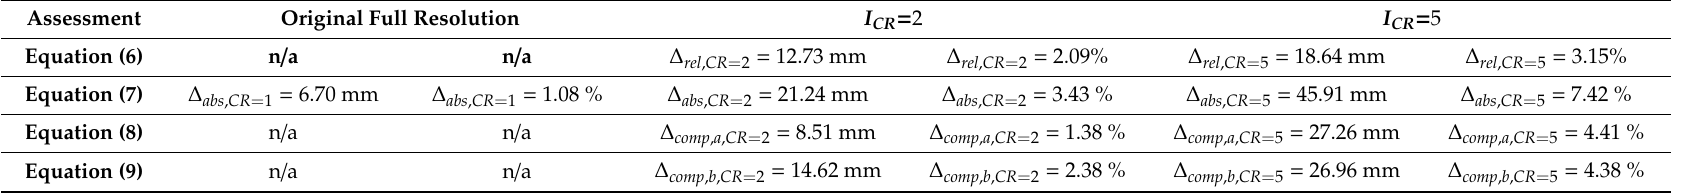
Table 11. Summary of the maximum values for the di ff erent calculated assessment